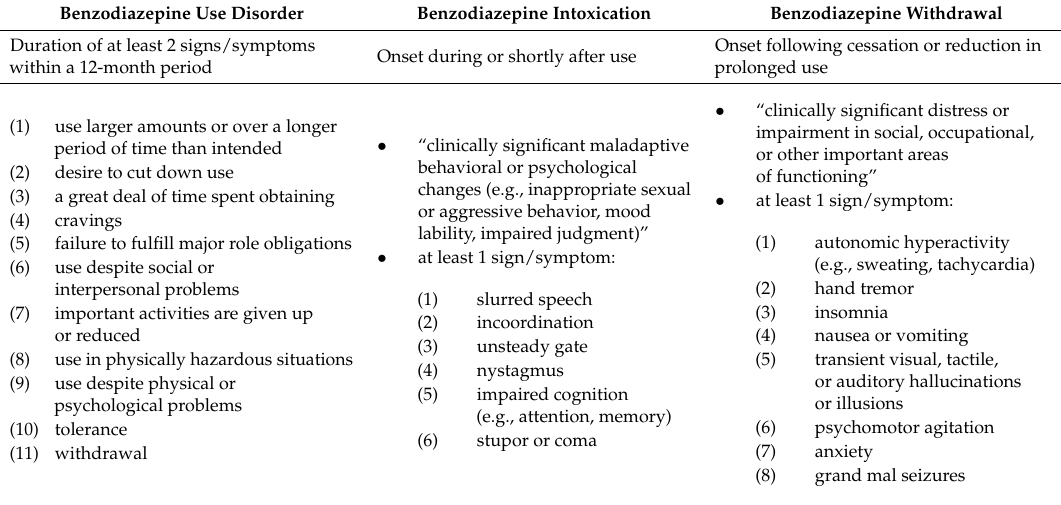
Table 4. Benzodiazepine-related disorders in the Diagnostic and Statistical Manual of Mental Disorders, 5th